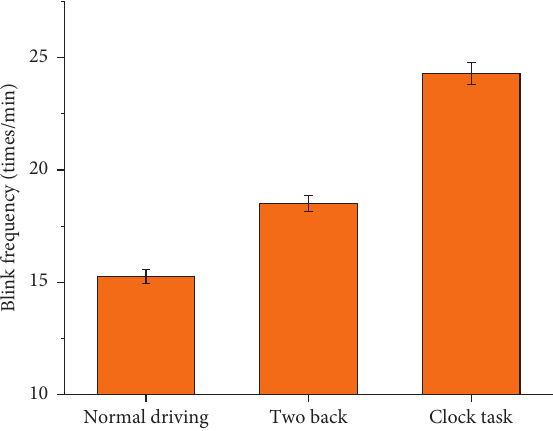
Figure 9: Main effect of the driving tasks on the blink frequency.